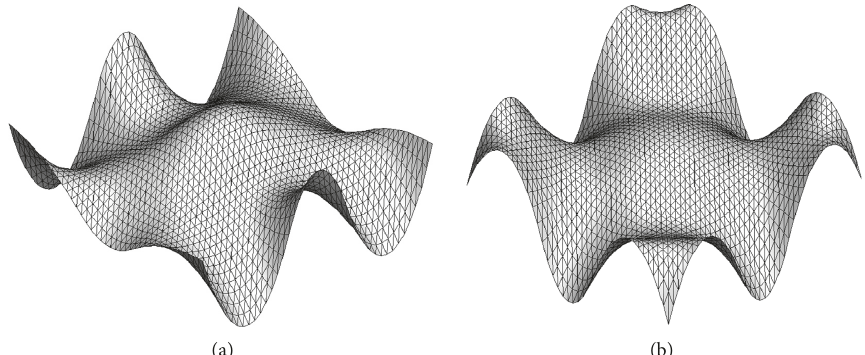
Figure 17: Optimal shapes and stacking sequences with increased number of variable control points (Approach 2). (a) Shell 2 [0 ° / 90 ° / − 45 ° 2 /45 ° / − 45 ° /0 ° 2 ] s . (b) Shell 3 [ − 45 ° /0 ° /90 ° /45 ° 2 /0 ° /90 ° / − 45 ° ] s Figure 16. Compared to Example 1 (Figure 7), the optimal shapes of Shells 1 and 2 are changed significantly by Ap-